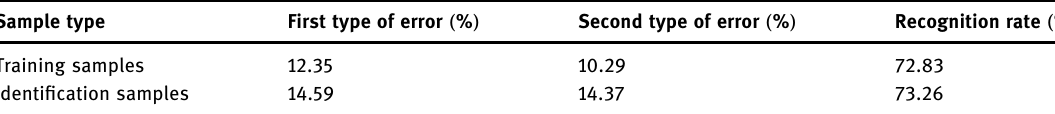
Table 1: Recognition results based on support vector machine algorithm Sample